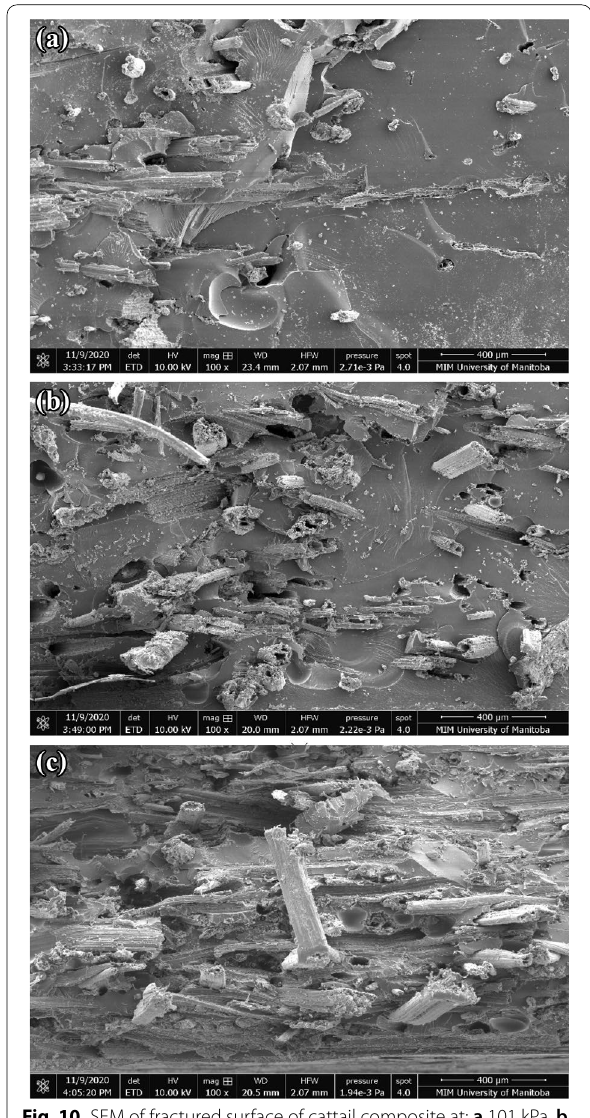
Fig. 10 SEM of fractured surface of cattail composite at: a 101 kPa, b 260 kPa, and c 560